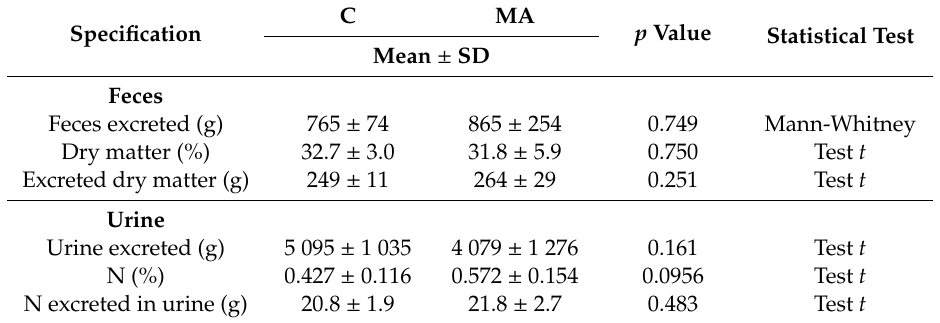
Table 4. Daily amounts of feces and urine excreted by growing pigs in the collection period (4 days). Specification